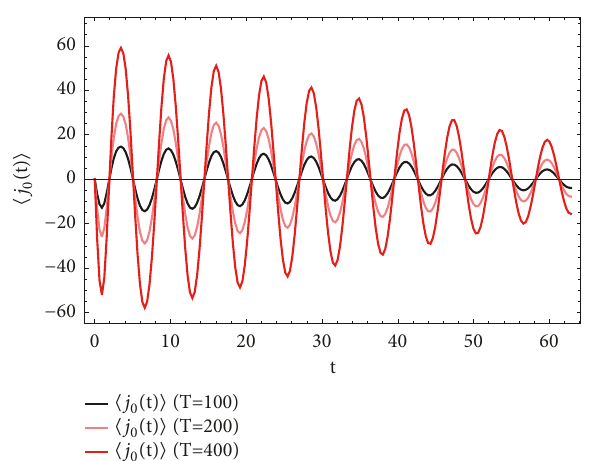
Figure 5: Dependence on temperature 𝑇 of the time evolution of PNA. As for horizontal axis, we use the dimensionless time 𝑡 = 𝜔 푟 (𝑥 0 − 𝑡 ) where we choose 𝜔 푟 = 0.35 . We fix a set of parameters 0 3, 0 3, 0 ) = (2, 3,1.58,0.35,10 −3 ) for all the lines. The as (̃𝑚 1 , ̃𝑚 2 , 𝐵,𝜔 3 , 𝐻 푡 0 black, light red, and red lines show the cases 𝑇 = 100,200 , and 400 ,